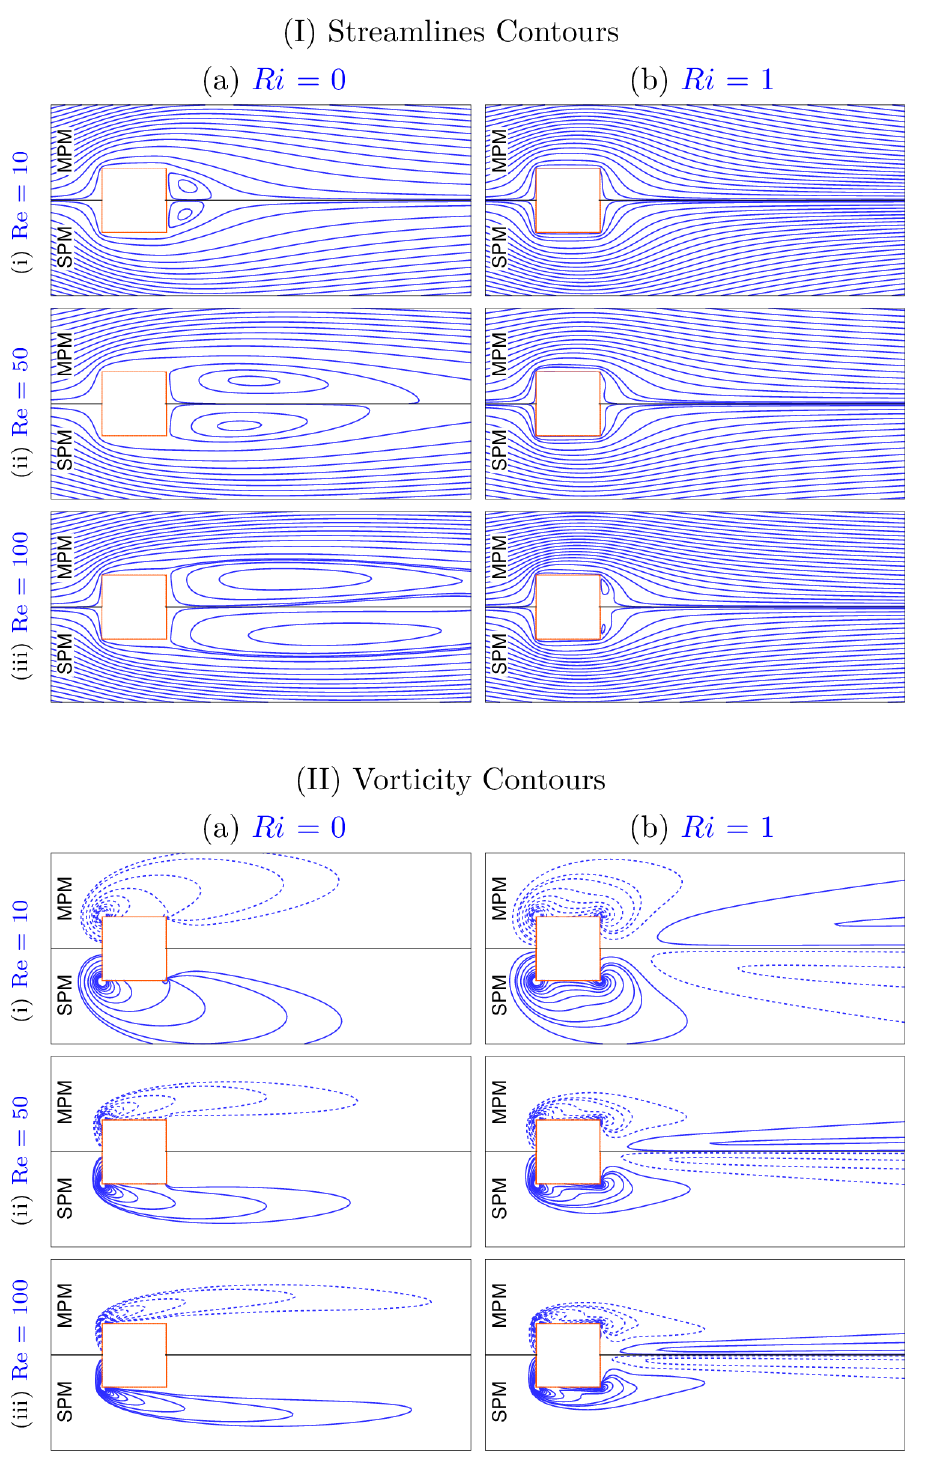
Figure 7. Comparison of single-phase and multi-phase modelling approach with ( a ) streamlines and ( b ) vorticity contours, for different values of Re and Ri at φ = 5%.